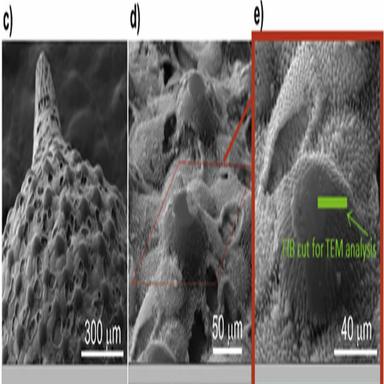
Topographic images of the diatom shell made via SEM: a). SEM image of the selected type of the diatom shell using a secondary electron detector; b). SEM image of the selected type of the diatom shell using the back-scattered electron detector; c). and d). higher magnification of the selected area of the diatom shell using the secondary electron detector; and e). SEM image of the diatom shell fragment with the marked area of the thin foil prepared for TEM cross-sectional observation.